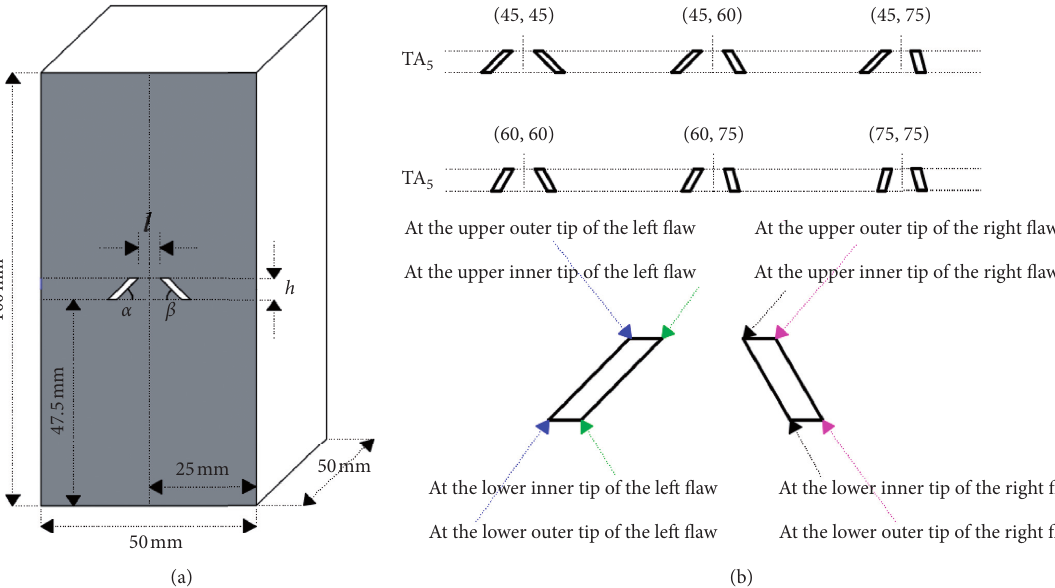
Figure 2: Schematic illustration of the initial position of a flaw (a) and description of flaw geometry with different inclination angles and initiation positions with respect to two prefabricated flaws